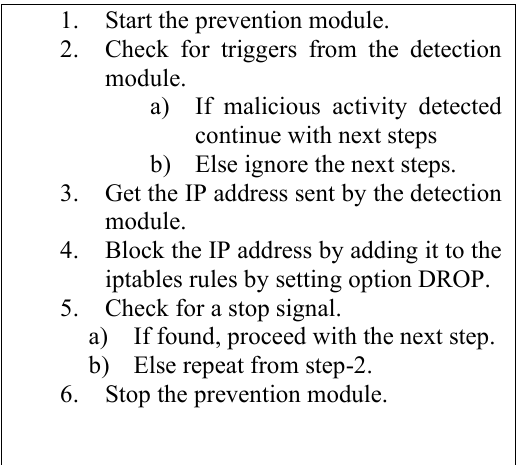
Fig.5 Algorithm for alert module of the proposed architecture